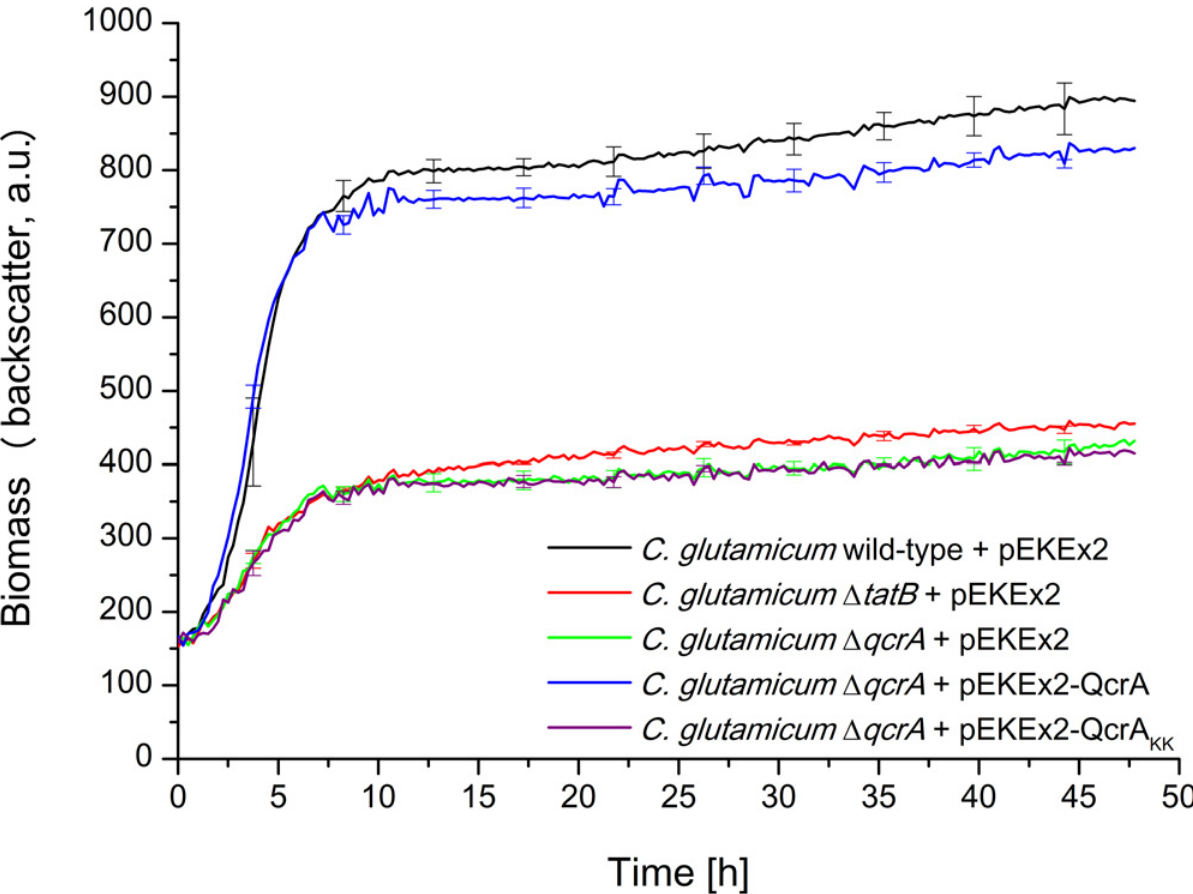
Fig 4. The correct membrane assembly of the physiologically important Tat substrate QcrA is required for unimpaired growth of C . glutamicum . Cells were inoculated to an OD 600 of 0.5 in 750 μ l BHIS medium containing 100 μ M IPTG and cultivated in 48-well FlowerPlates in a BioLector system for 48 h at 30°C, 1100 rpm under constant 85% relative humidity. Growth of the respective C . glutamicum strains, as indicated in the figure, was monitored as backscattered light (620 nm; signal gain factor 20) in 15 min intervals. The growth curves show one representative experiment of three independent biological replicates. Standard deviations are given for 10 selected time points. a.u.: arbitrary units.